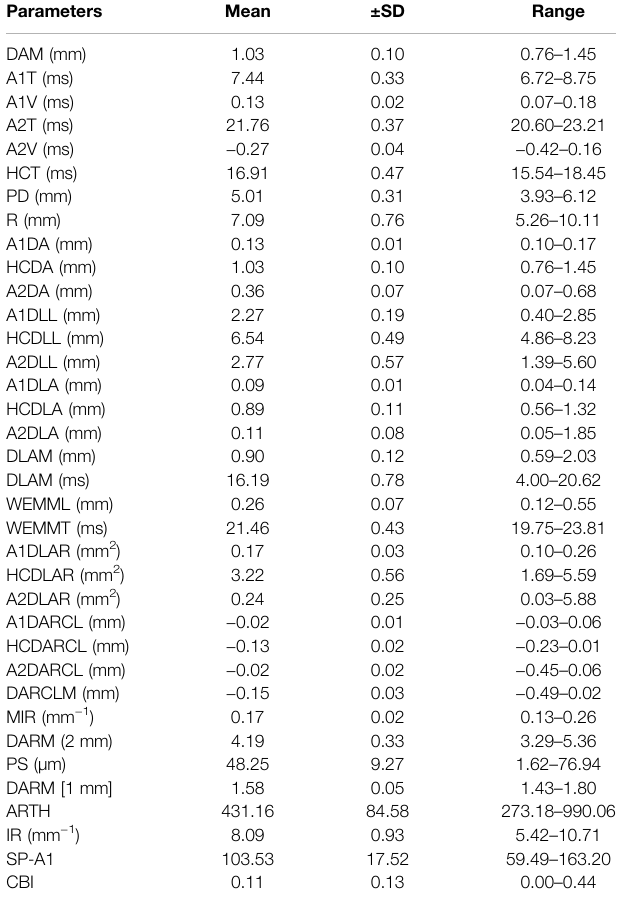
TABLE 3 | Dynamic Corneal Response parameters data of